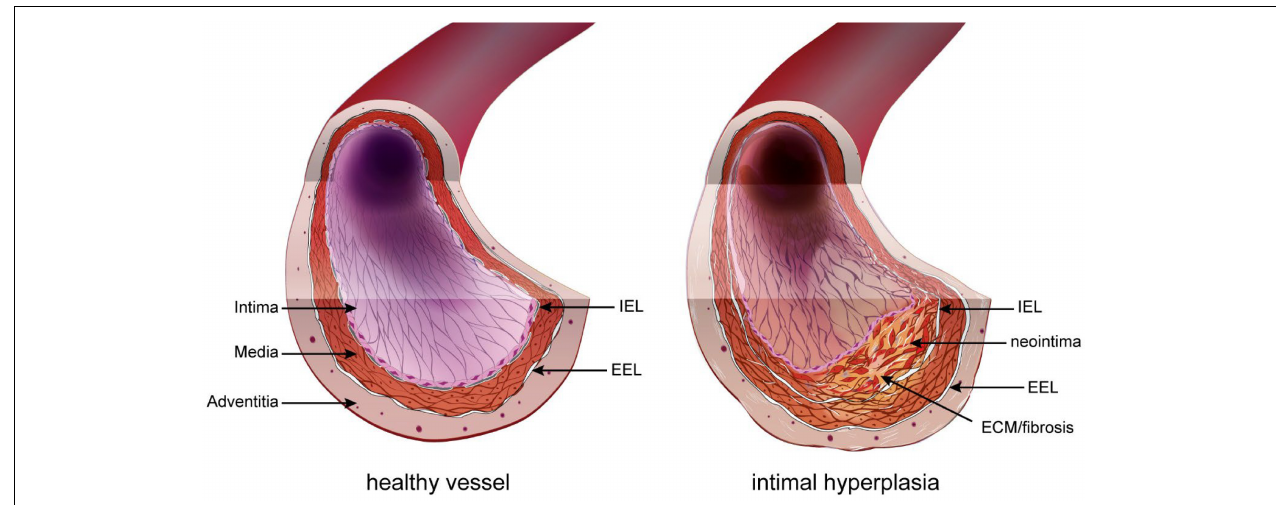
FIGURE 1 | Intimal hyperplasia. In the healthy vessel (left), the inner intimal layer is composed only of the endothelium (pink layer). Under the endothelium sits the basement layer and internal elastic lamina (IEL). The media layer is composed of elastic fibers and smooth muscle cells (SMC). The outer part of the media and adventitia are separated by the exterior elastic lamina (EEL). Restenosis following vascular surgery is the formation of a neointima layer between the IEL and endothelium. It is composed of proliferating SMC-like cells of different origin and extracellular matrix